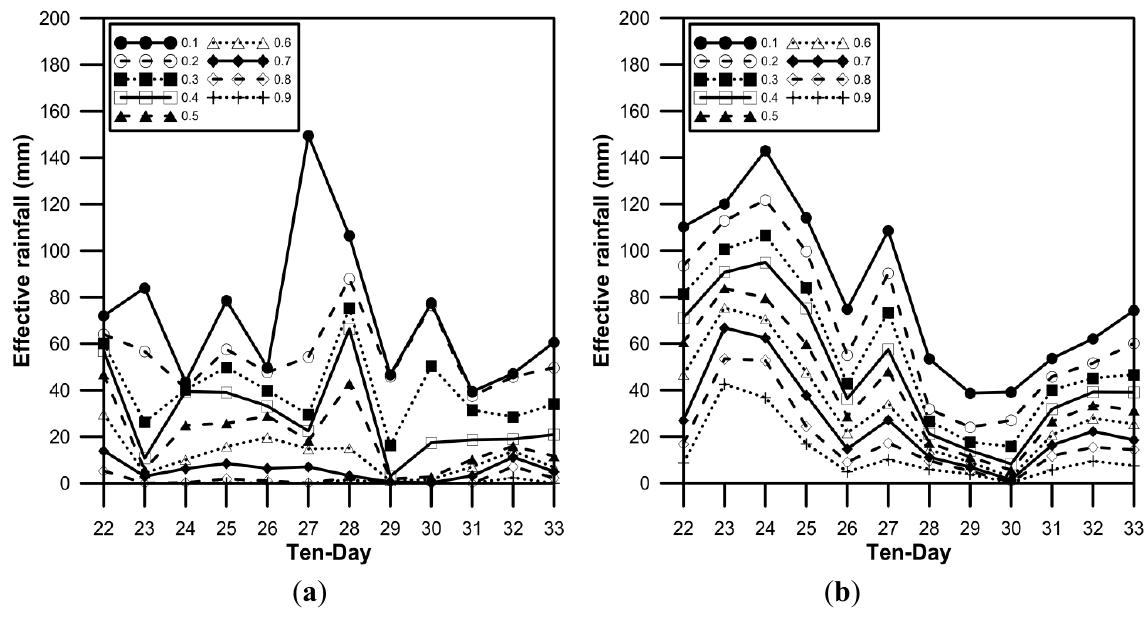
Figure 16. Exceedance probability distribution of effective rainfall at each ten-day during the second cropping season. ( a ) present (2004–2011); ( b ) future